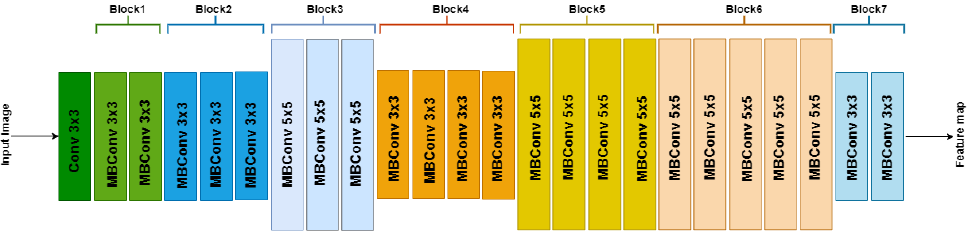
Figure 3. Architecture of EfficientNetB1 with MBConv as basic building blocks. The overall architecture can be divided into seven blocks, as shown. Each MBConvX block is shown with the corresponding filter size.